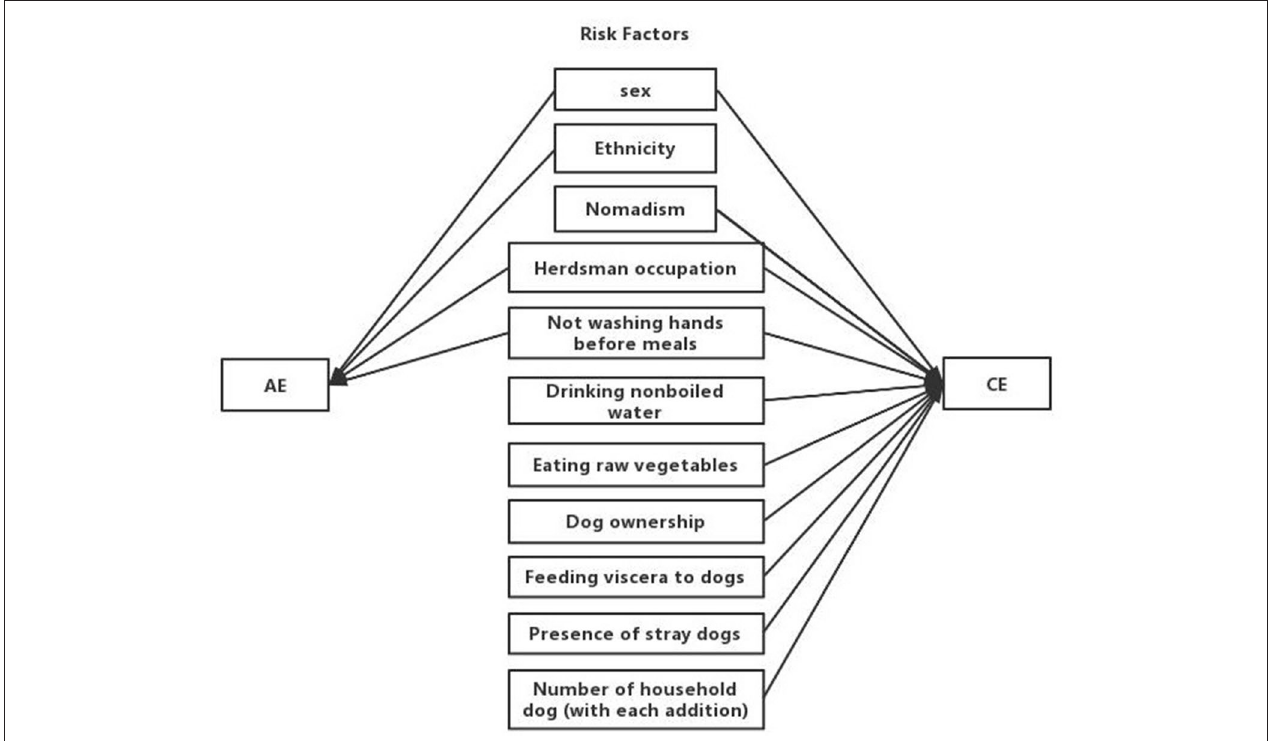
FIGURE 2 | Concept map of risk factors for AE and